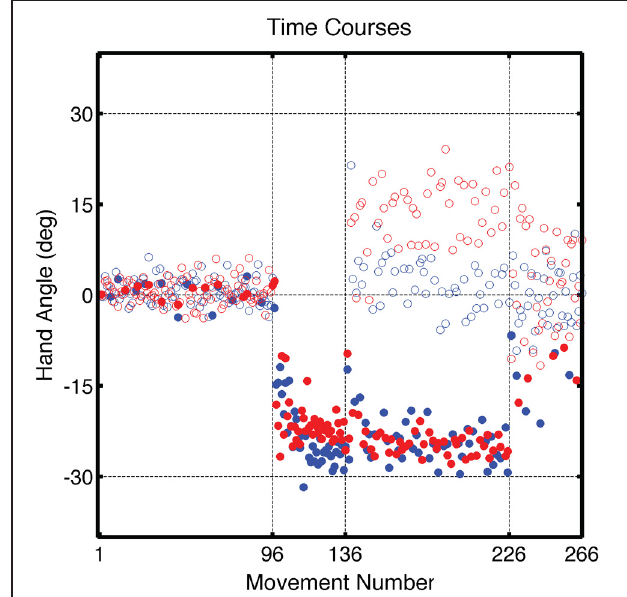
FIGURE 3 | Group averaged endpoint hand angle across trials in Experiment 1. The visuomotor mapping was veridical for the first 96 trials (Base1, Base2, Base3). Dashed vertical lines mark when the visual perturbation was present during the Training block (movements 97–136) and during the Test block (movements 137–226). Filled circles represent movements to the training target location and open circles represent movements to other target locations (blue: CircleRotation group; red: LineTranslation group). Endpoint position for the LineTranslation group was converted from Cartesian to polar coordinates since the visual perturbation was identical in polar space for the two